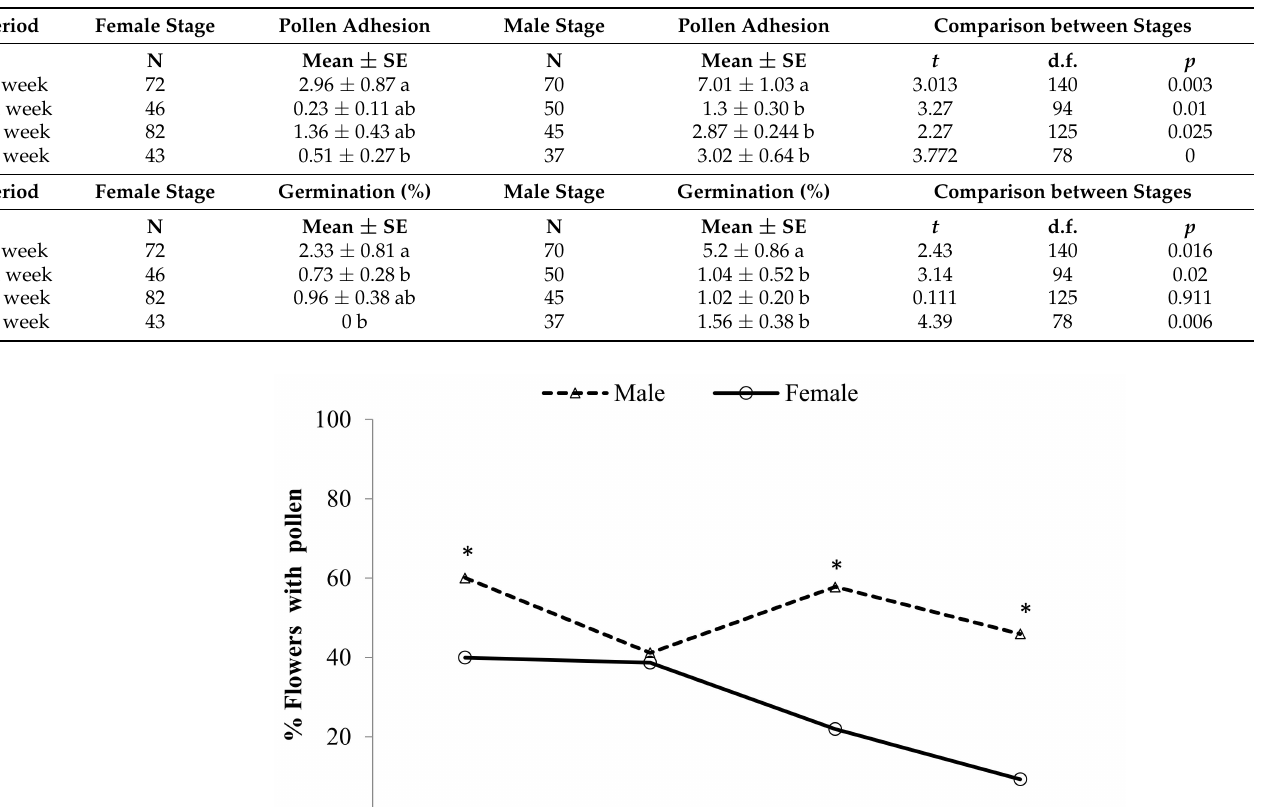
Table 1. Pollen adhesion and percentage of pollen germination (mean ± standard error) in all the flowers collected at the end of the female and male stages. Means with the same letter within each stage and for each parameter evaluated were not significantly different at p < 0.05 (GLM followed by Tukey HSD test). Comparison of pollen adhesion and germination between both stages were determined using a Student’s t -test.